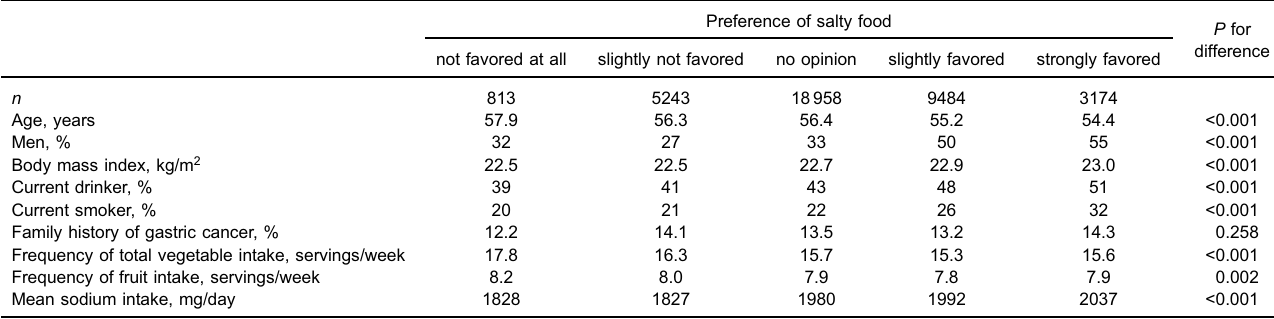
Table 1. Age- and sex-adjusted characteristics of the subjects according to preference for salty food